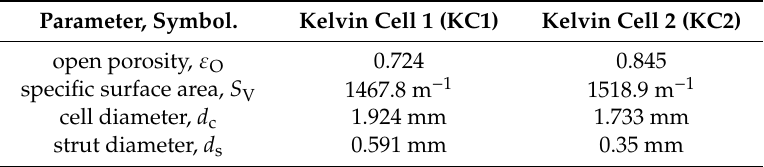
Figure 1. Illustration of model with boundary conditions. The orange highlighted fluid properties are investigated in this study. Table 1. Properties of the investigated Kell cell lattices.